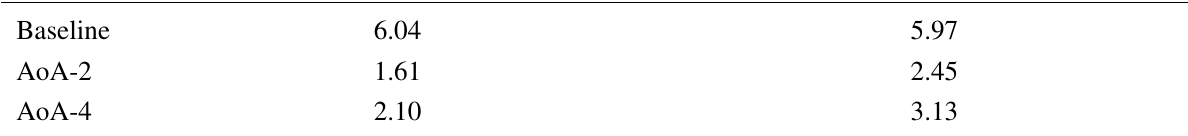
Table 3. Error estimation of PSP against Kulite and